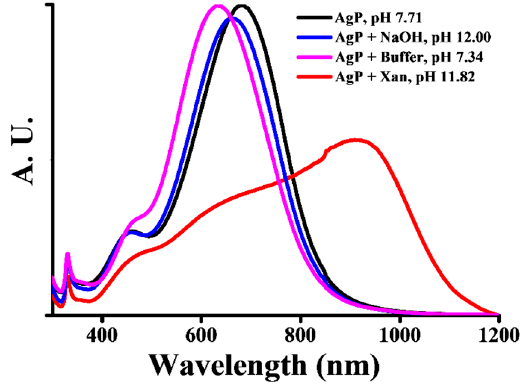
Figure 2. UV-Vis spectrum of AgP with addition of NaOH, buffer and Xan.